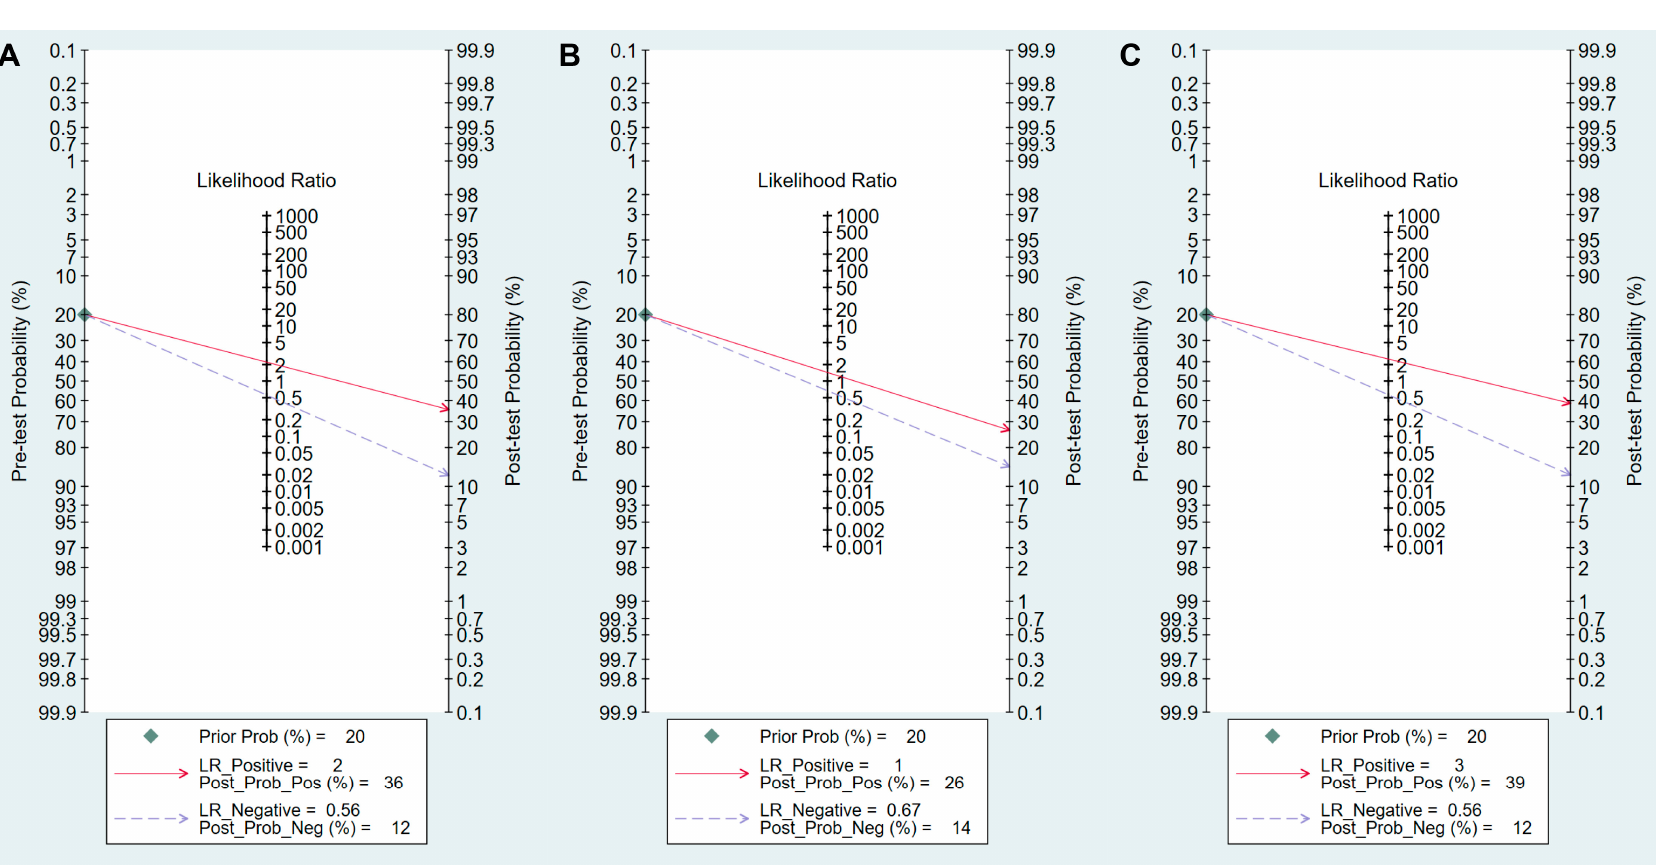
Figure 9. Fagan’s normogram for the diagnosis of GC. ( A ) cut-off value with PG I ≤ 70 ng/mL and PG I/PG II ratio ≤ 3, ( B ) cut-off value with PG I ≤ 70 ng/mL, ( C ) cut-off value with PG I/PG II ratio ≤ 3. GC, gastric cancer; PG, pepsinogen; LR, likelihood raio.